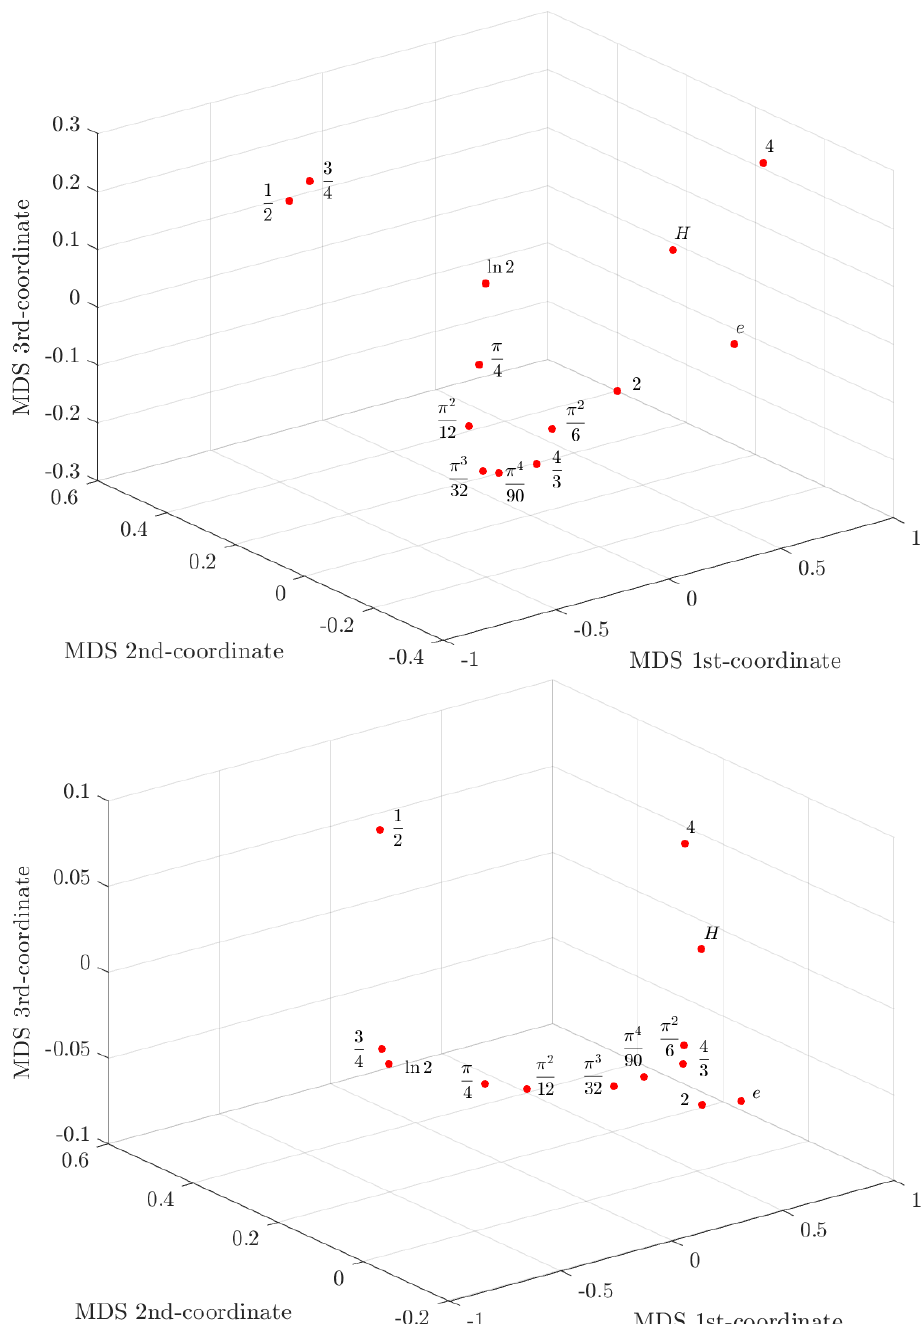
Figure 2. MDS loci of the numerical series S i , i = 1, . . . ,13, produced by the Euclidean ( top ) and Tchebychev ( bottom ) distances, d Eu and d Tc , for r =